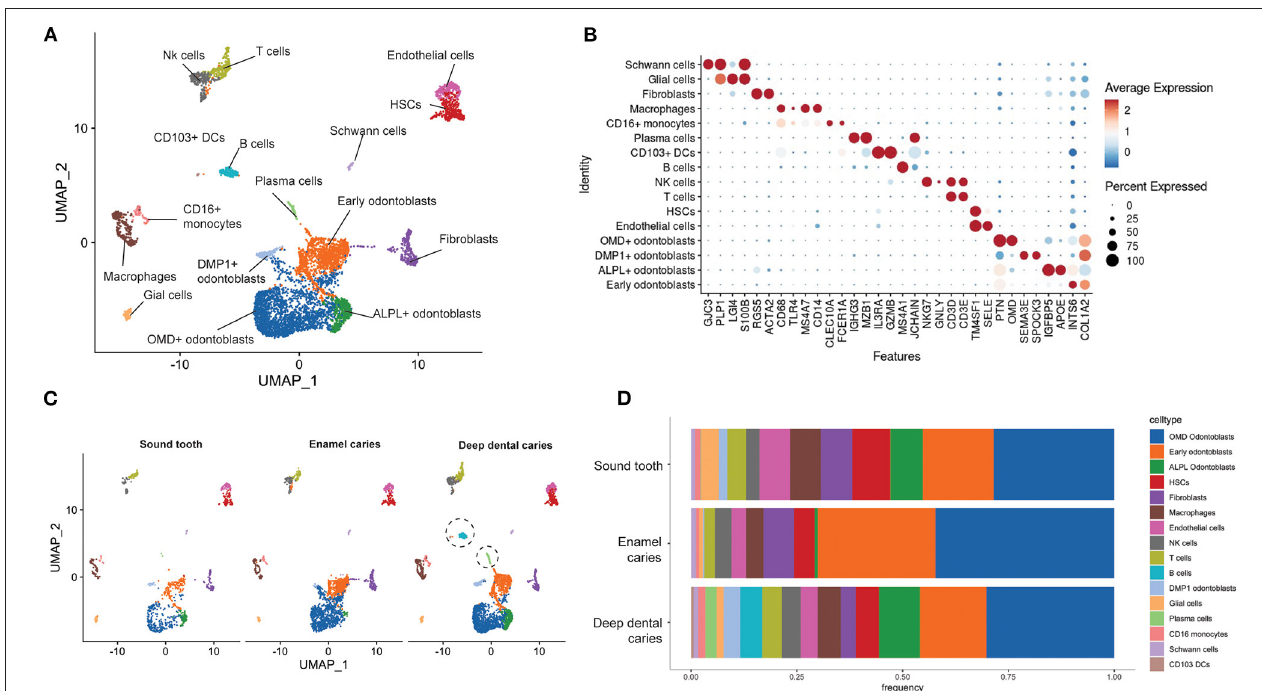
FIGURE 2 | The cell population in dental pulp in sound, enamel, and deep carious teeth. (A) Integrated UMAP of the dental pulp samples: sound, enamel caries and deep dental caries. (B) The average expression levels of the marker genes used in the cell type annotation. (C) UMAP plots showing different distributions of cell populations in the sound, enamel, and deep dental caries. Dashed circles indicated the enrichment of B cells, plasma cells and CD103 + DCs in the deep dental caries (D) Stacked bar plots comparing the percentages of cell populations from the sound, arrested and deep dental